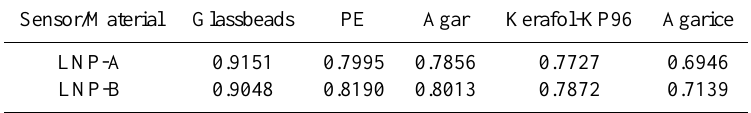
Table 2. Calibration factors derived for the different materials and